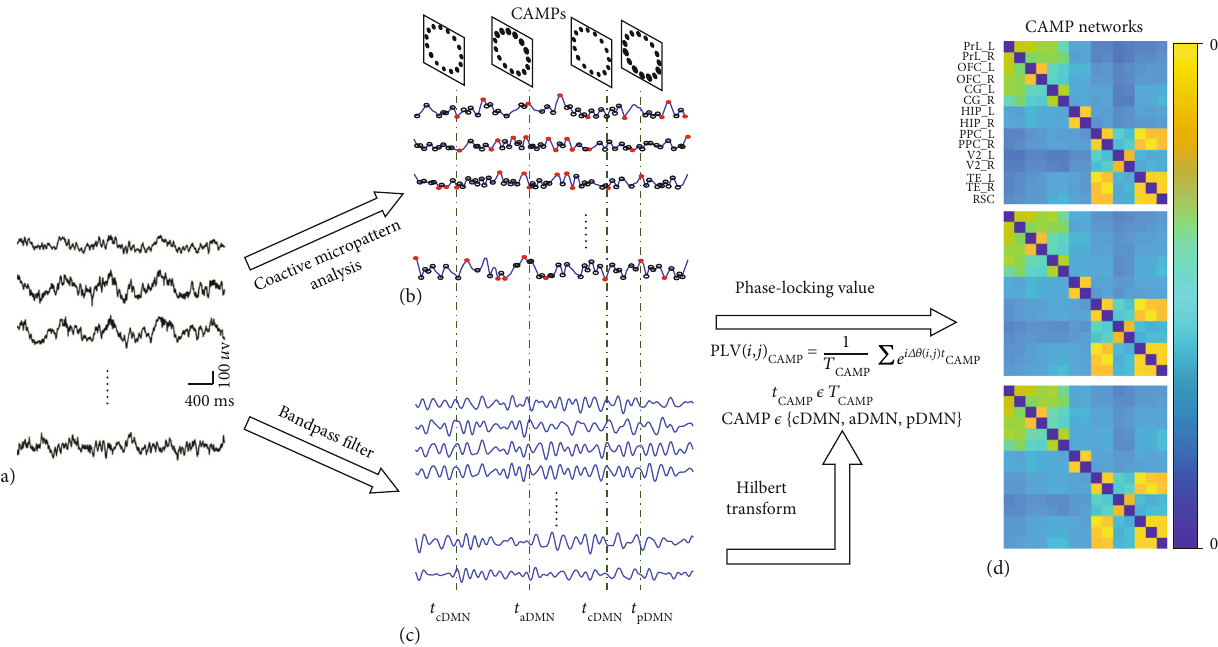
Figure 1: Illustration of the algorithm of CAMP networks. (a) The originally recorded signals from DMN regions. (b) The CAMPs in the dynamics of DMN activity. (c) Low-frequency bandpass- fi ltered signals from the original signals. In the present study, we passed the signals through a 1-4 Hz bandpass fi lter. (d) The three CAMP networks were identi fi ed for the three CAMPs by the PLV